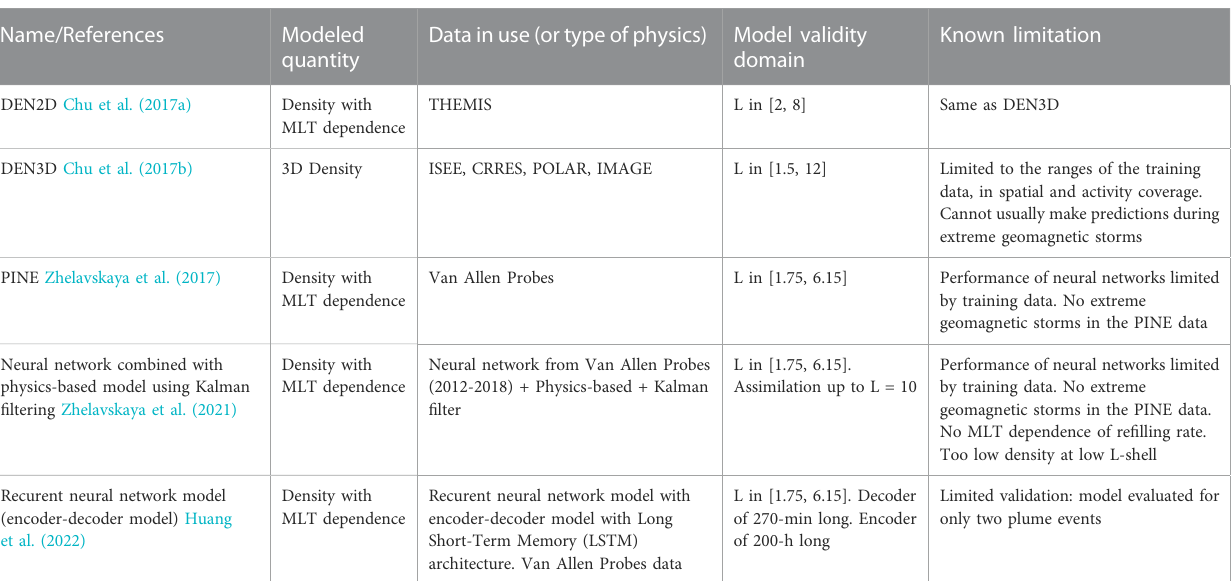
TABLE 4 Machine learning models of the electron density discussed in this